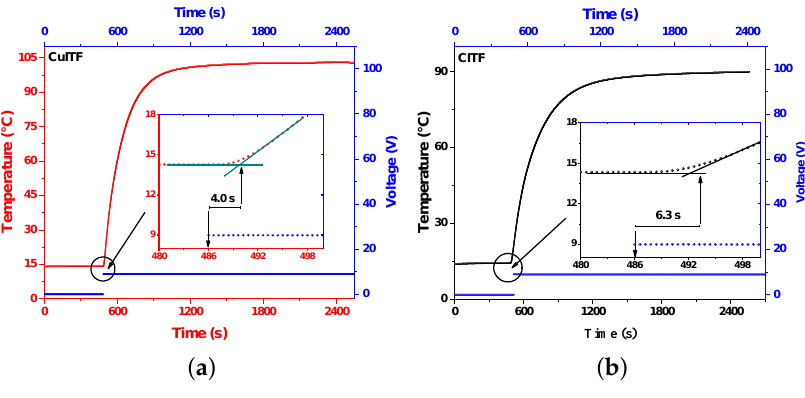
Figure 7. Dead time for ( a ) CuITF and ( b )